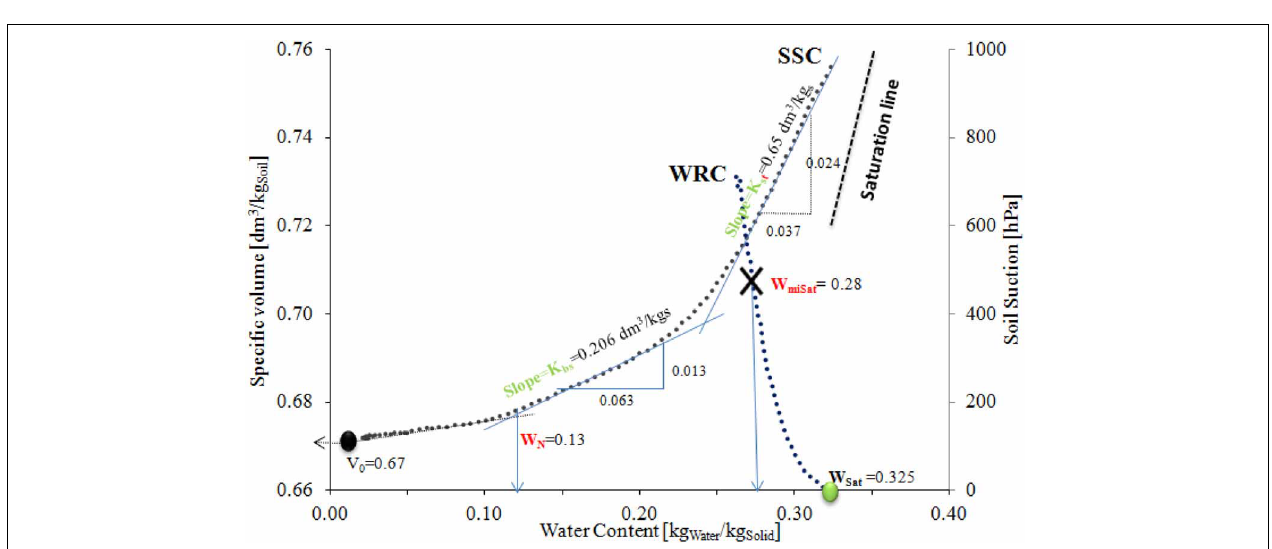
the parameters are fixed to the extracted values, while the gray dots and texts indicate that these parameters could be changed during the optimization.